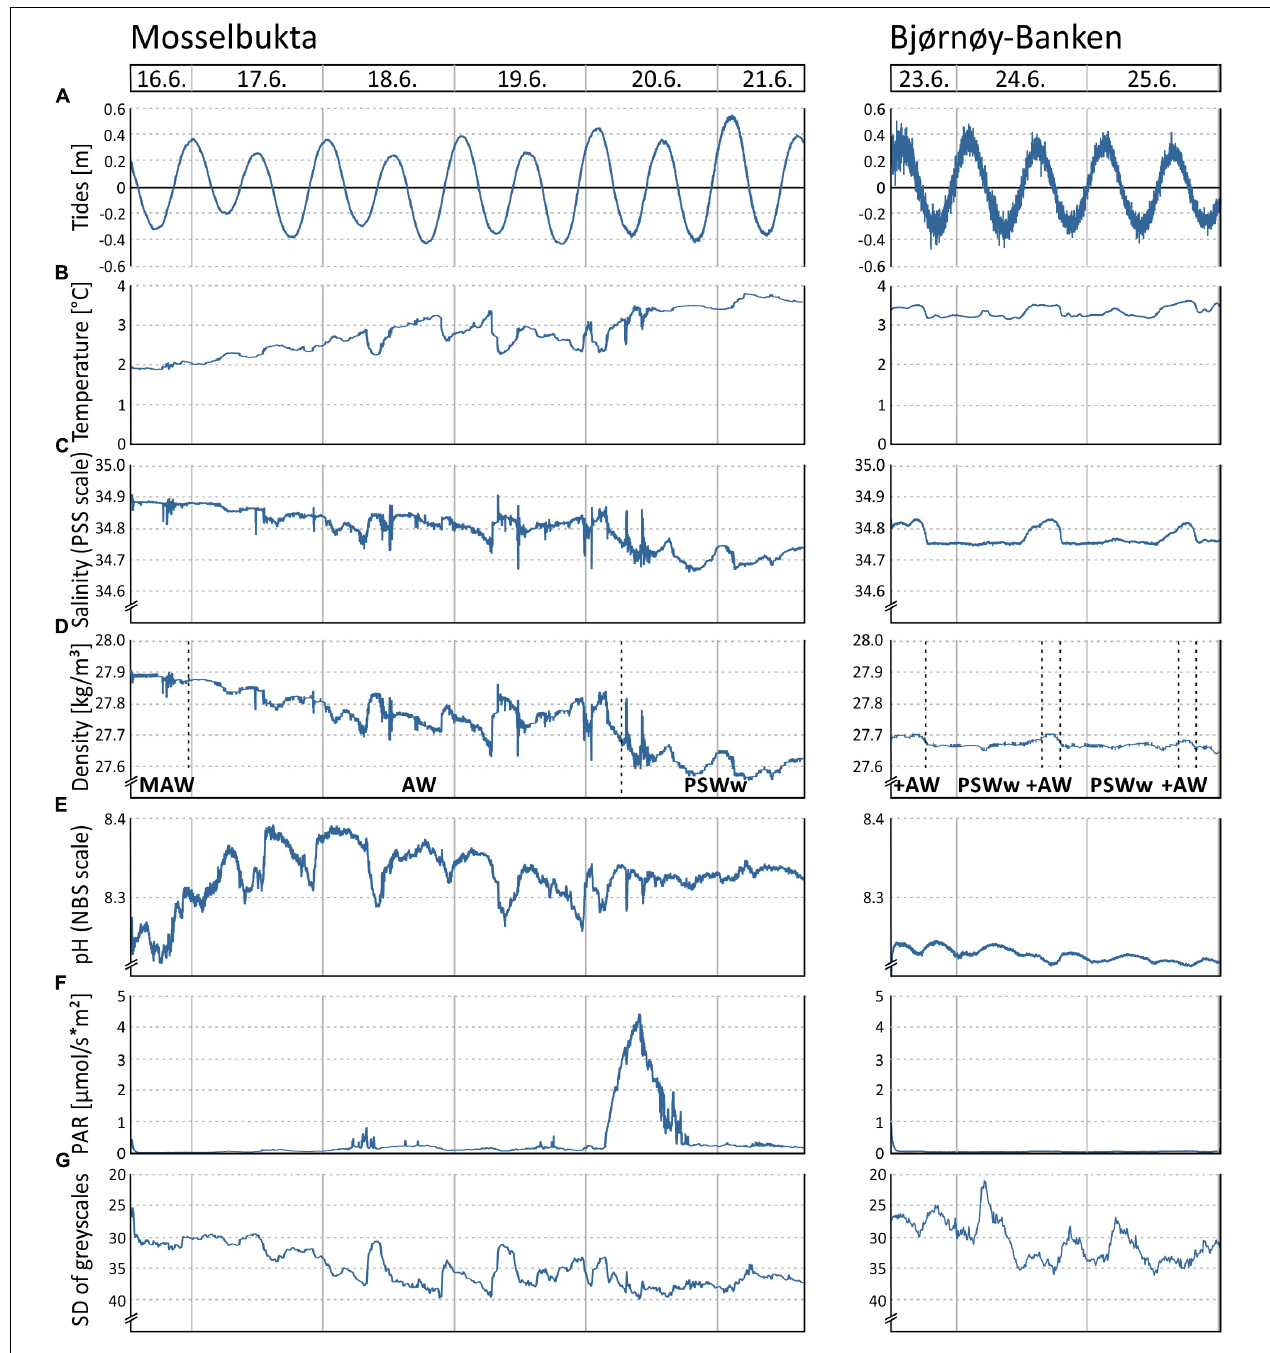
FIGURE 5 | Various environmental parameters recorded by the RBR logger and Ocean Imaging Systems camera on the SaM Lander during two short-term deployments at 46 m water depth in Mosselbukta and at Bjørnøy-Banken, respectively, during the MSM55 cruise in June 2016: (A) Tidal curve (calculated from depth readings). (B) Temperature. (C) Salinity. (D) Seawater density (calculated from temperature and salinity), with indicated water masses of the Atlantic Water from the south (AW), Modified Atlantic Water from the Arctic Ocean (MAW), and warm Polar Surface Water (PSWw). (E) Seawater pH. (F) Photosynthetically active radiation (PAR). (G) Turbidity proxy (standard deviation of mean grey scales in each image of the lander’s camera